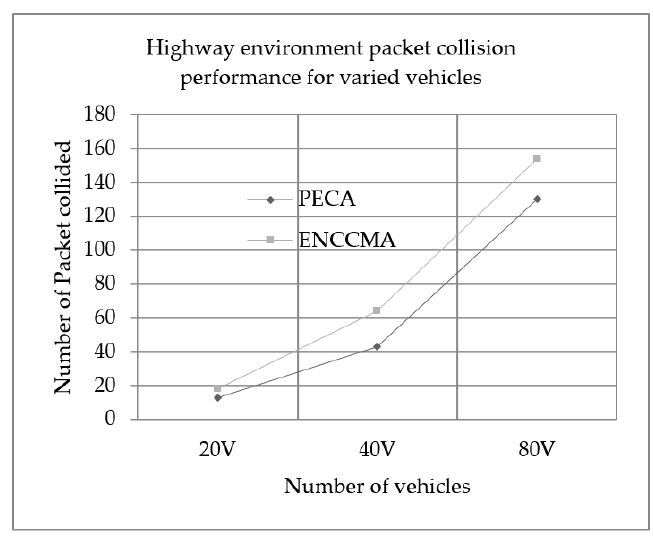
Figure 8. Highway environment packet collision performance for varied vehicles.